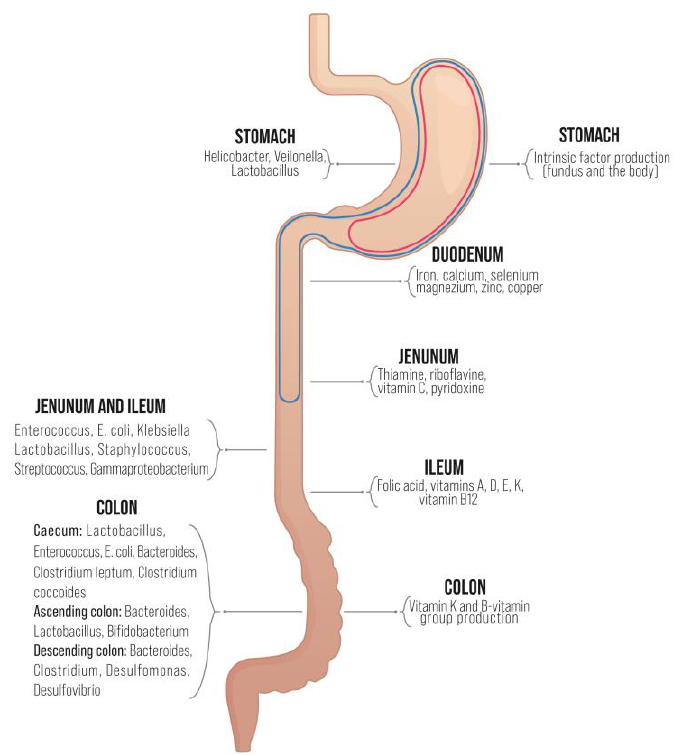
Figure 2. Distribution of micronutrient absorption / biosynthesis sites within the gut [94] and the associated microbiota [95]. Marked areas are excluded after RYGB (blue) and VSG (red).